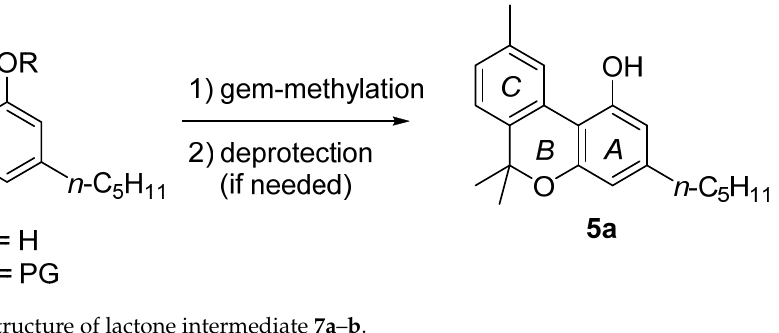
Figure 3. The structure of lactone intermediate 7a – b.